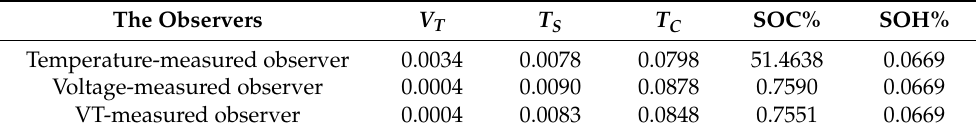
Table 6. RMSE of EKF using wrong